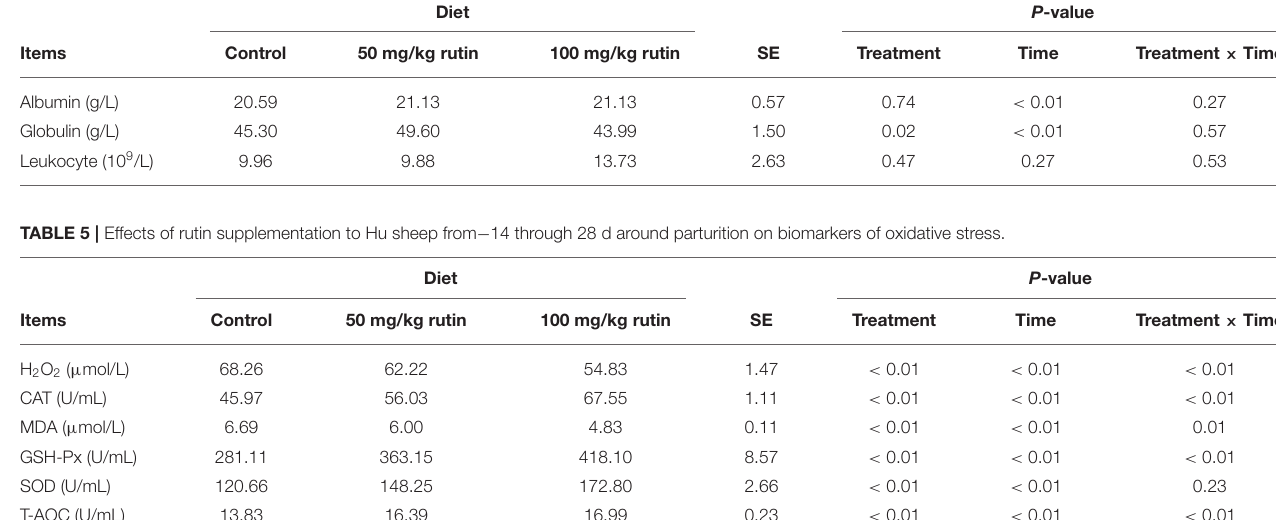
TABLE 4 | Effects of rutin supplementation to Hu sheep from − 14 through 28 d around parturition on biomarkers of inflammation. Diet P -value Items Control